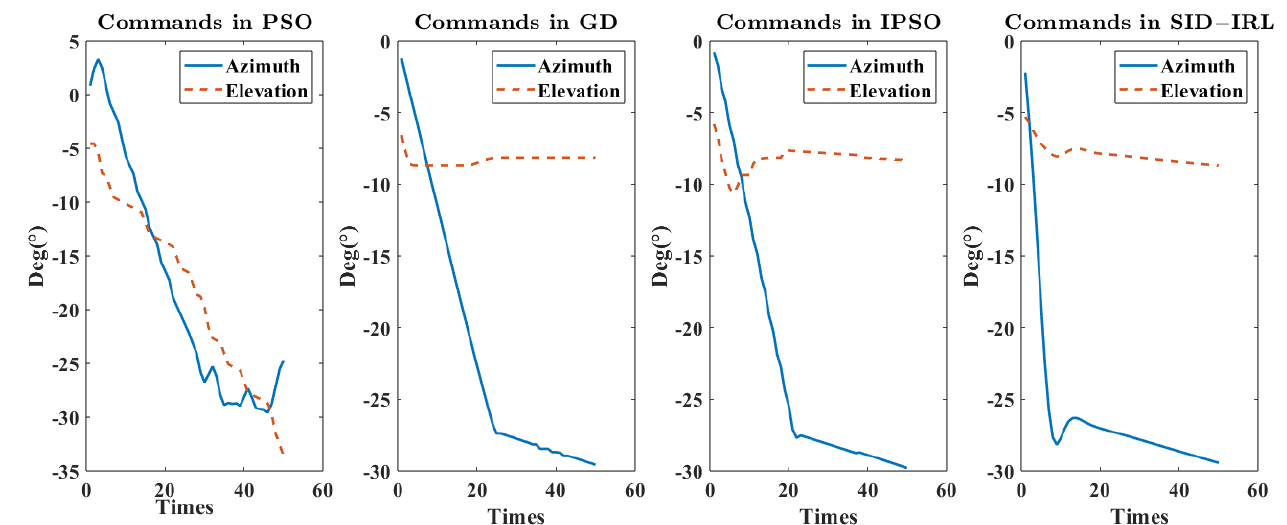
Figure 11. Command of the projectile angles in case 1.